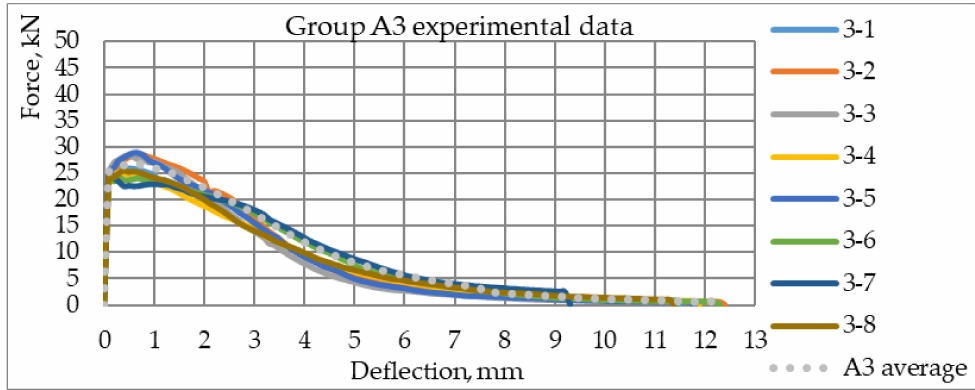
Figure 17. Load—sample center vertical deflection graphs for the specimens in Group A3.